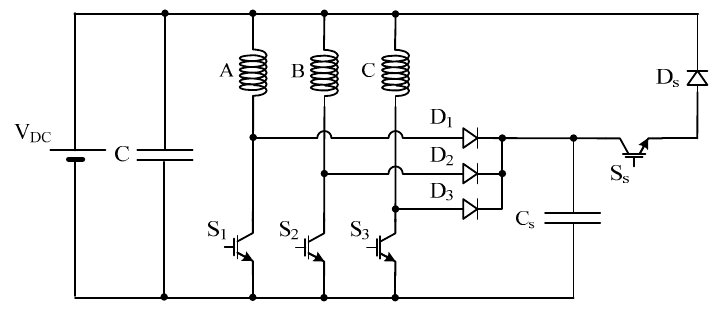
Figure 8. Sood topology. Figure 8. Sood